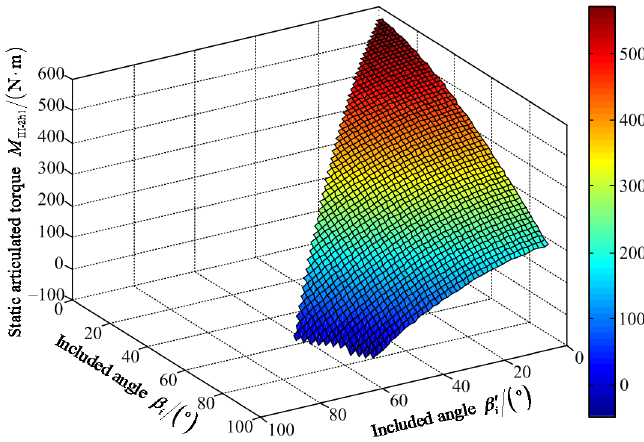
Figure 21. Variable tendency chart of static articulated torque M III ‐ 2h1 with changes of β i ′ and β i .